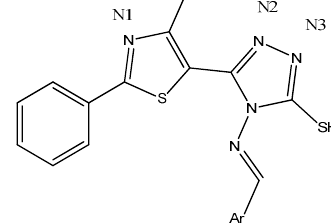
Table 4. Predicted binding affinity and polar contacts between compounds B1 – B15 and the active site of CYP51.